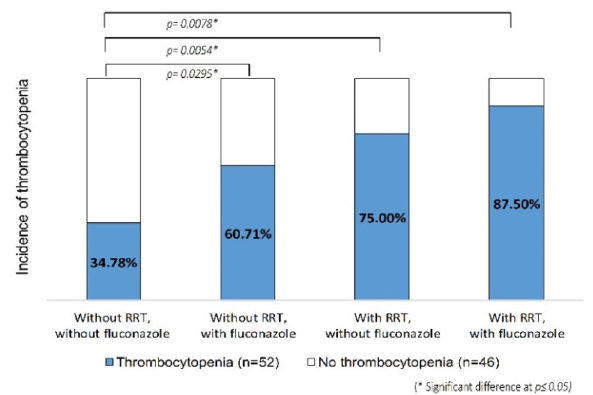
Figure 3. Incidence of linezolid-associated thrombocytopenia among patients who received both RRT and fluconazole, RRT alone, fluconazole alone, and denied RRT and